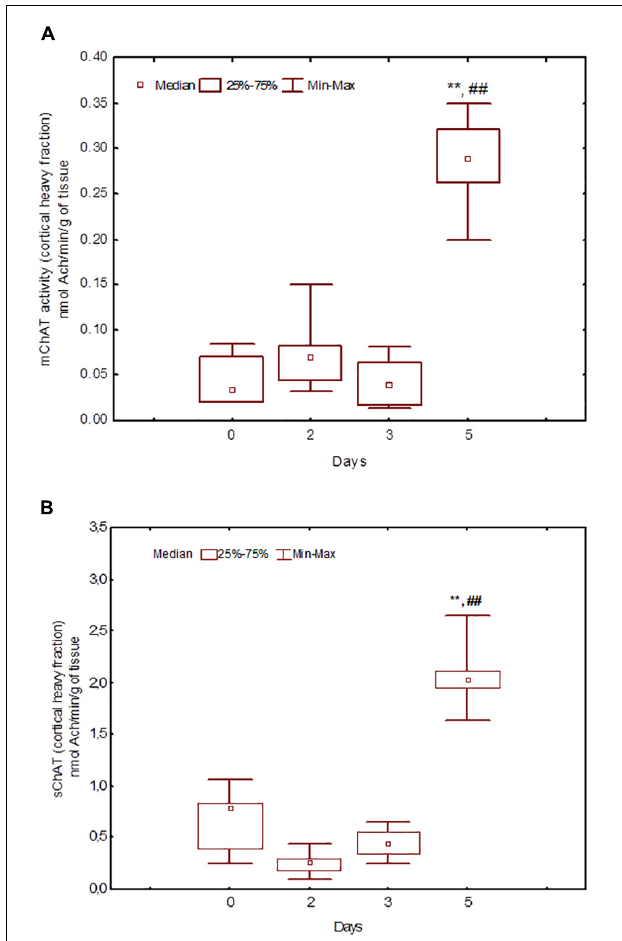
FIGURE 6 | Choline acetyltransferase (ChAT) activity in heavy synaptosomal sub-fractions from the neocortex in naïve rats (day 0) and after 2, 3, or 5 days of training in the Morris water maze (MWM). The y -axis is the ChAT activity (nmoles ACh/min/g tissue). (A) mChAT from heavy synaptosomal fraction, (B) sChAT from heavy synaptosomal fraction, ** p < 0.01 relative to naïve rats. ## p < 0.01 relative to the previous time